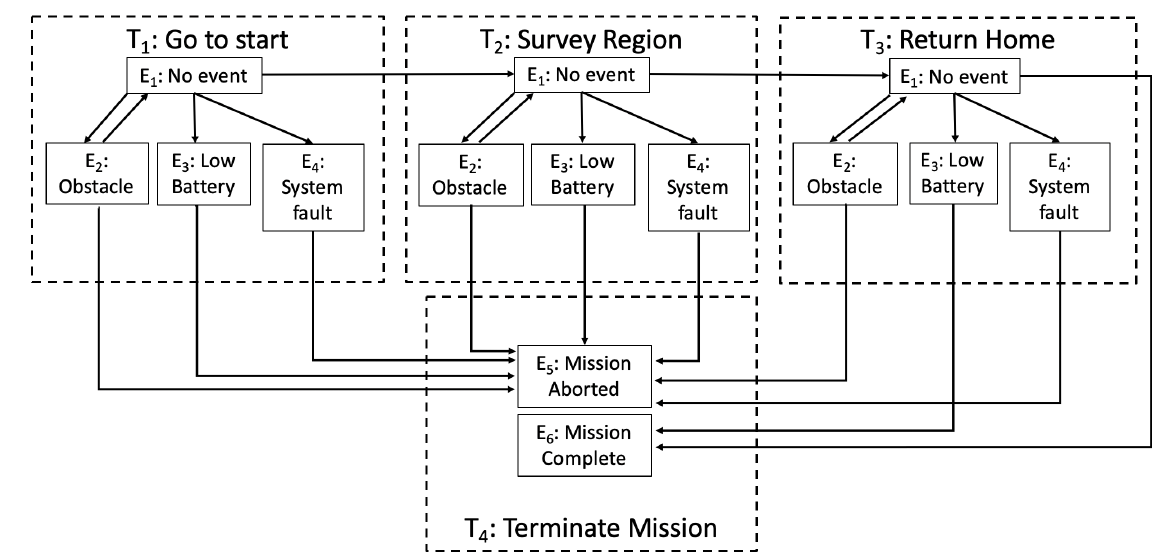
Figure 2. Graphical overview of the example mission for a given scenario.